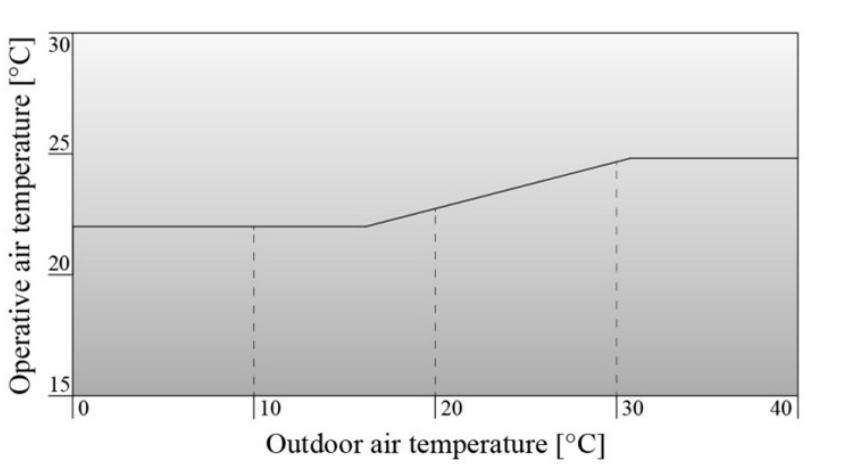
Figure 2. Example of a standard-based IEQ indicator (operative air temperature) and its value as a function of the outdoor air temperature (based on standards DIN EN 15251 and DIN EN ISO 7730).